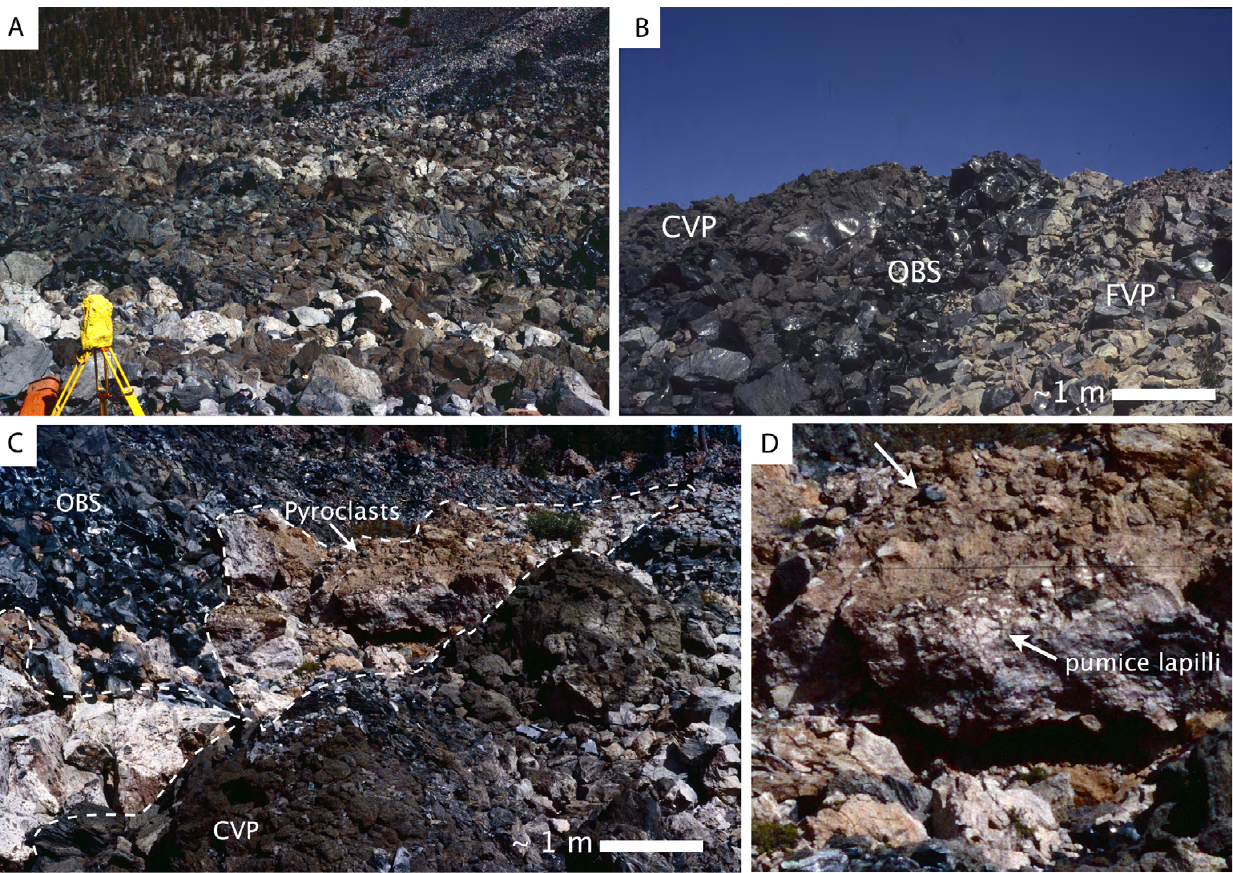
Figure 3: [A]–[B] Field photographs showing typical lava flow top morphology and texture on Big Glass Mountain. Lava comprises meter-sized angular blocks of finely and coarsely vesicular pumice (FVP and CVP) and dense black obsidian (OBS). Frames [C] and [D]) show rare exposures of pyroclastic mantle deposits on normal obsidian lava flow top. In frame [C], pyroclastic deposits are confined to a small swale (enclosed in white dashed lines) in the flow, which corresponds to a valley formed during folding of the flow top. These pyroclasts are shown in magnified view in frame [D]. Like pyroclastic material in the breccia zones, these deposits have a reddish hue that contrasts sharply from the surrounding lava. The overall grain size is highly variable, ranging from lapilli to bomb size fragments, and grading from blocky pyroclastic material on top to progressively denser partially welded pyroclasts in contact with the lava at its base. The presence of pumice lapilli and unconsolidated obsidian blocks suggest these materials were deposited from the air on an actively effusing lava (see also equivalent features at Cordón Caulle in the Supplementary